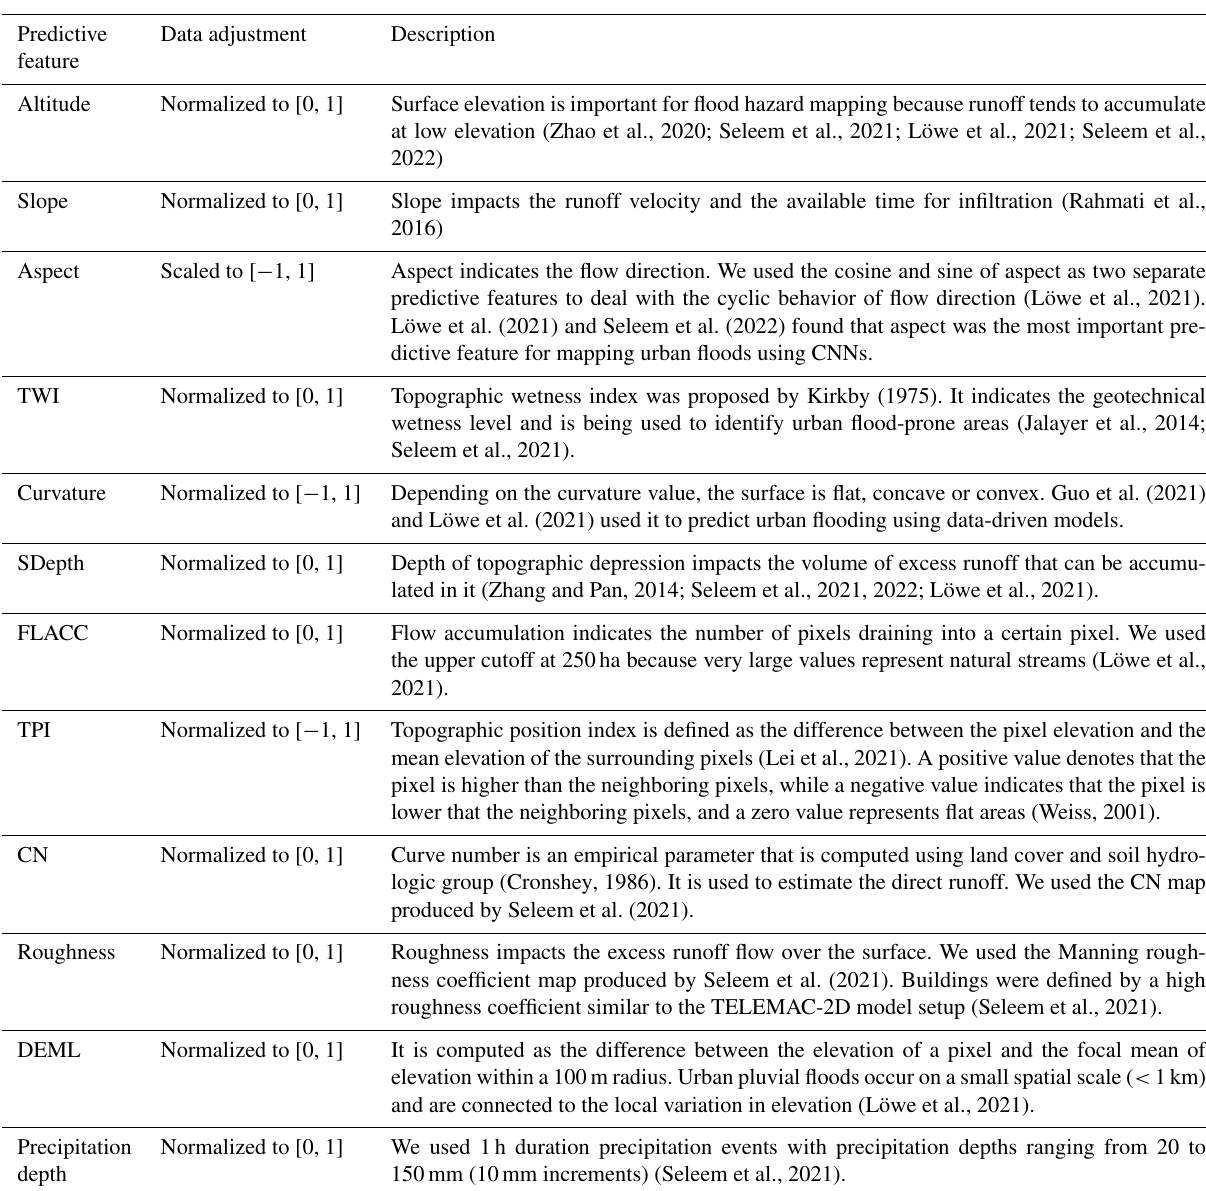
Table 2. Spatial predictive features used to train the data-driven